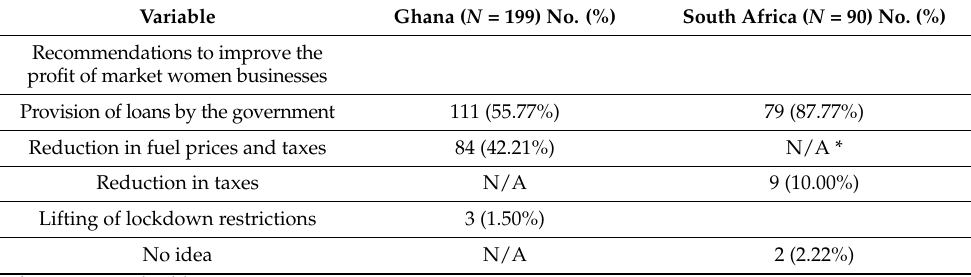
Table 7. Recommendations to improve the profit margins of businesses. Variable Ghana ( N = 199) No. (%) South Africa ( N = 90) No. (%) Recommendations to improve the profit of market women businesses Provision of loans by the government 111 (55.77%) 79 (87.77%) Reduction in fuel prices and taxes 84 (42.21%) N/A * Reduction in taxes N/A 9 (10.00%) Lifting of lockdown restrictions 3 (1.50%) No idea N/A 2 (2.22%) N/A *—not